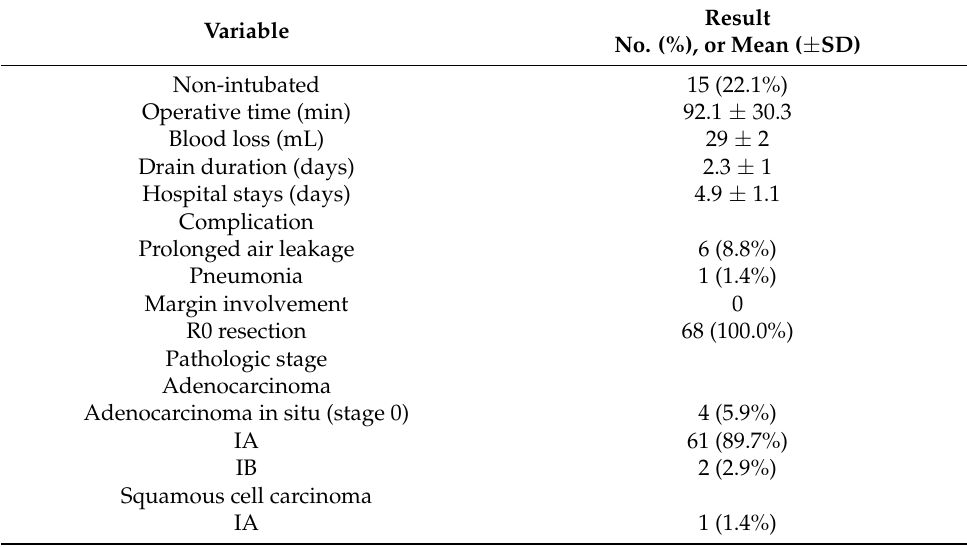
Table 3. Short-term postoperative outcomes and